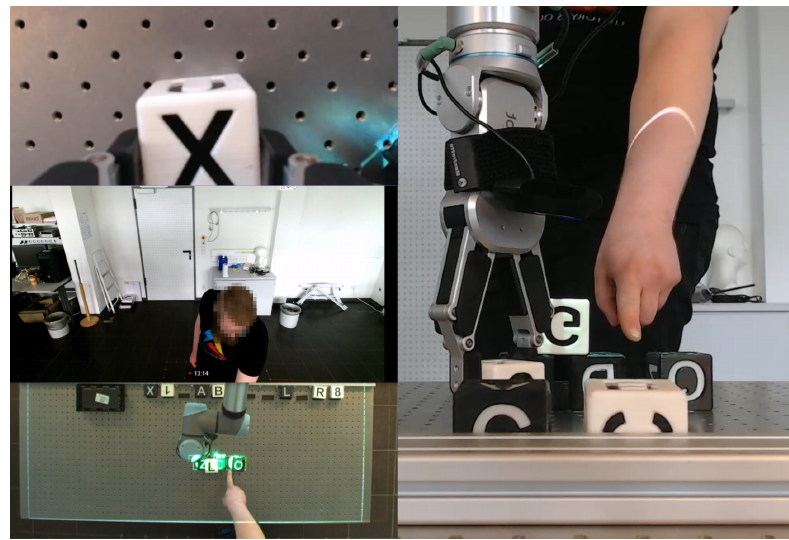
Figure 1. A participant using a pointing gesture for the robot to place the